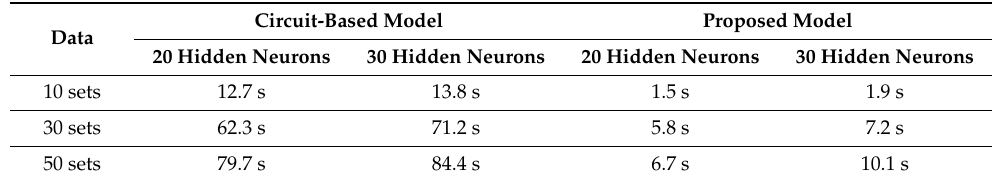
Table 3. Training time comparison of the